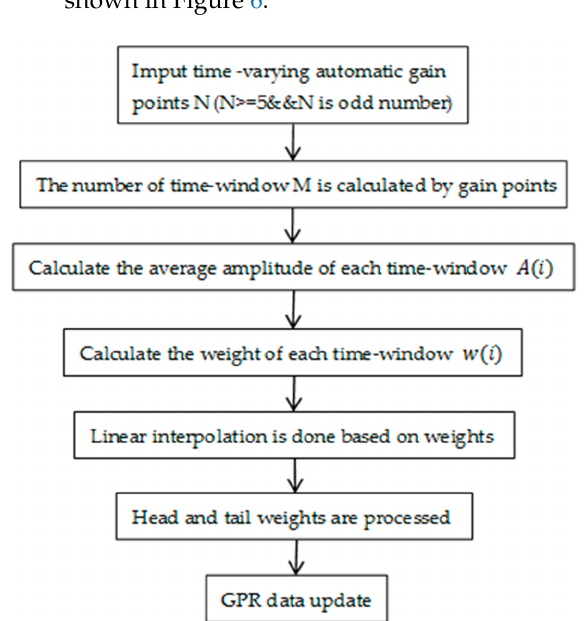
Figure 6. Flow chart of calculation program based on time-varying automatic gain.